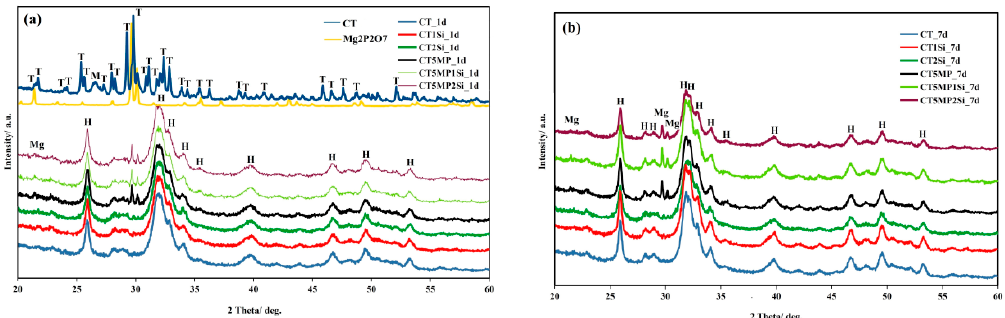
Figure 1. XRD patterns of origin CT5MP powder mixture and cements after 1 ( a ) and 7 days setting ( b ) in SBF at 37 °C. (Mg: Mg 2 P 2 O 7 (JCPDS 32-0626), H: hydroxyapatite (PDF4 01-071-5048), M: monetite (JCPDS 09-0080), T: TTCP JCPDS 25-1137)).